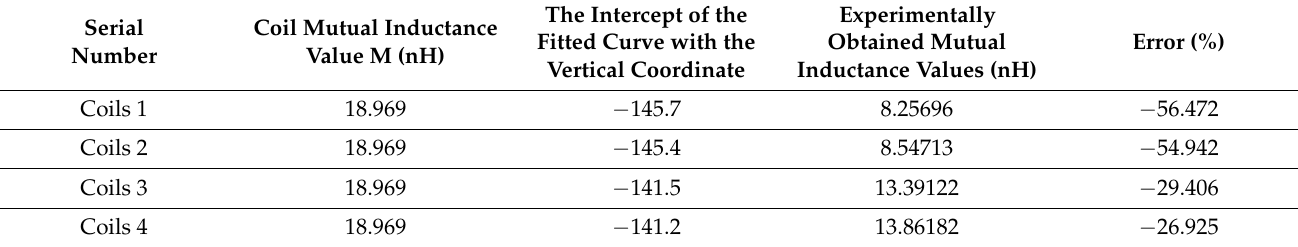
Table 4. Bode diagram of coil 5–7.